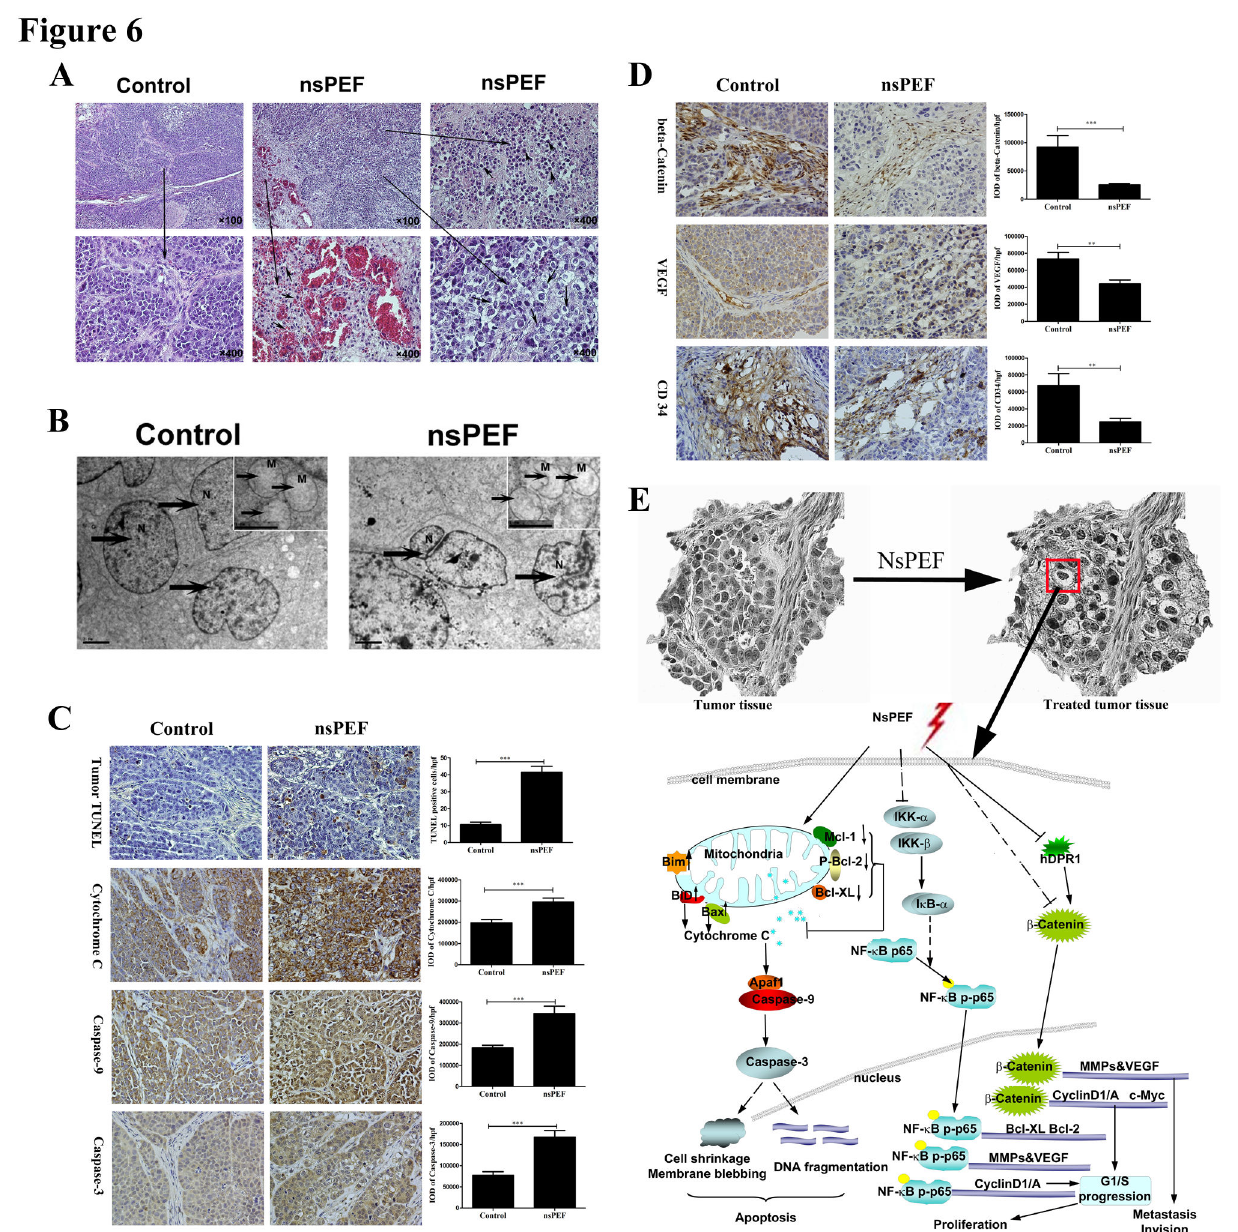
Figure 6. NsPEF induces tumor apoptosis, destroyed tumor microenvironment and depressed angiogenesis in tumor tissue in vivo , and its molecular mechanism analysis. (A) Representative tumor histology. Tumor sections were stained with H and E. Original magnification, 100× & 400×. Cell shrinkage, angiorhagia, and leucocytes infiltration were found. (B) Ultrastructure for tumor tissue with or without nsPEF was observed by TEM. N: nuclear changes including nuclear shrinkage and apoptotic body formation. M: mitochondria degeneration. (C) Tumor apoptosis was detected by TUNEL assay, and apoptosis relative proteins including Cytochrome C, Caspase-9 and Caspase-3 were determined by immunohistochemistry staining (IHC). IHC results were analyzed by Image Pro-Plus software. IOD, integrated optical density. hpf, high-powered field. Original magnification, 400×. ***p<0.001. (D) Protein expressions of β-Catenin, VEGF and CD34 were detected by IHC staining. **p<0.01, ***p<0.001. IHC results were analyzed by Image Pro-Plus software. IOD, integrated optical density. hpf, high-powered field. Original magnification, 400×. (E) Molecular mechanism analysis of nsPEF inhibiting cancer growth in vitro and in vivo .